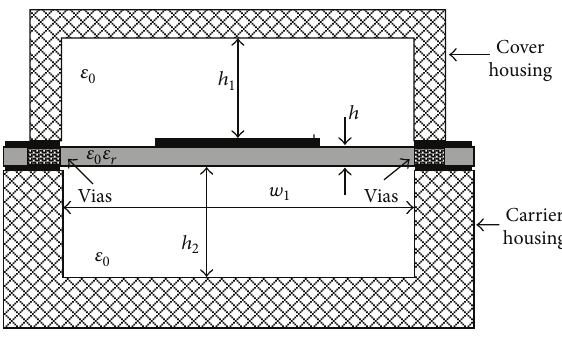
Figure 1: Cross-sectional view of the suspended stripline (SSL) channel.